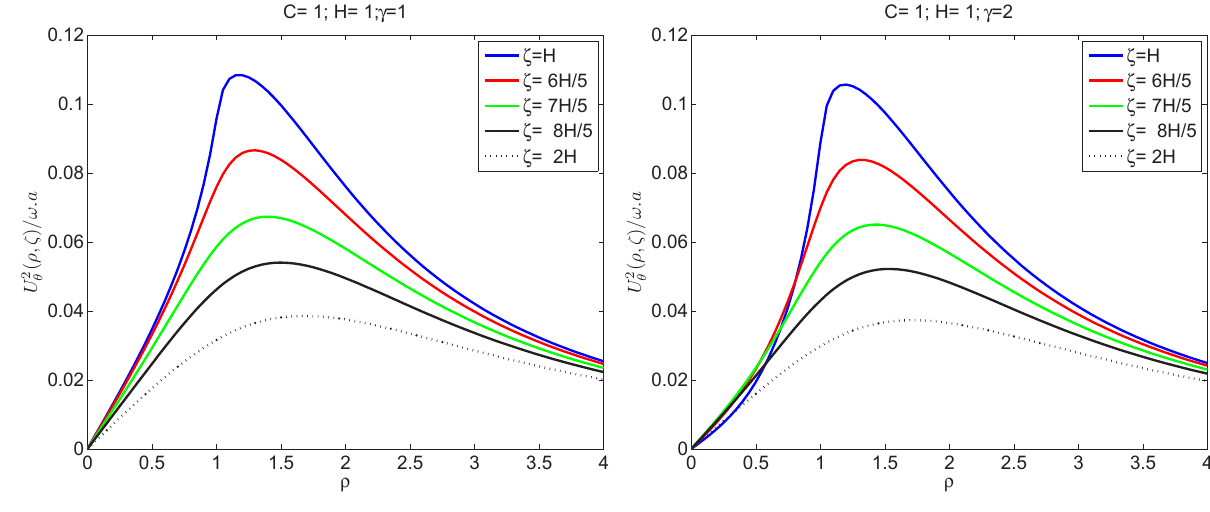
Figure 6: Tangential displacement u θ2 versus ρ for various ξ, z≥h.